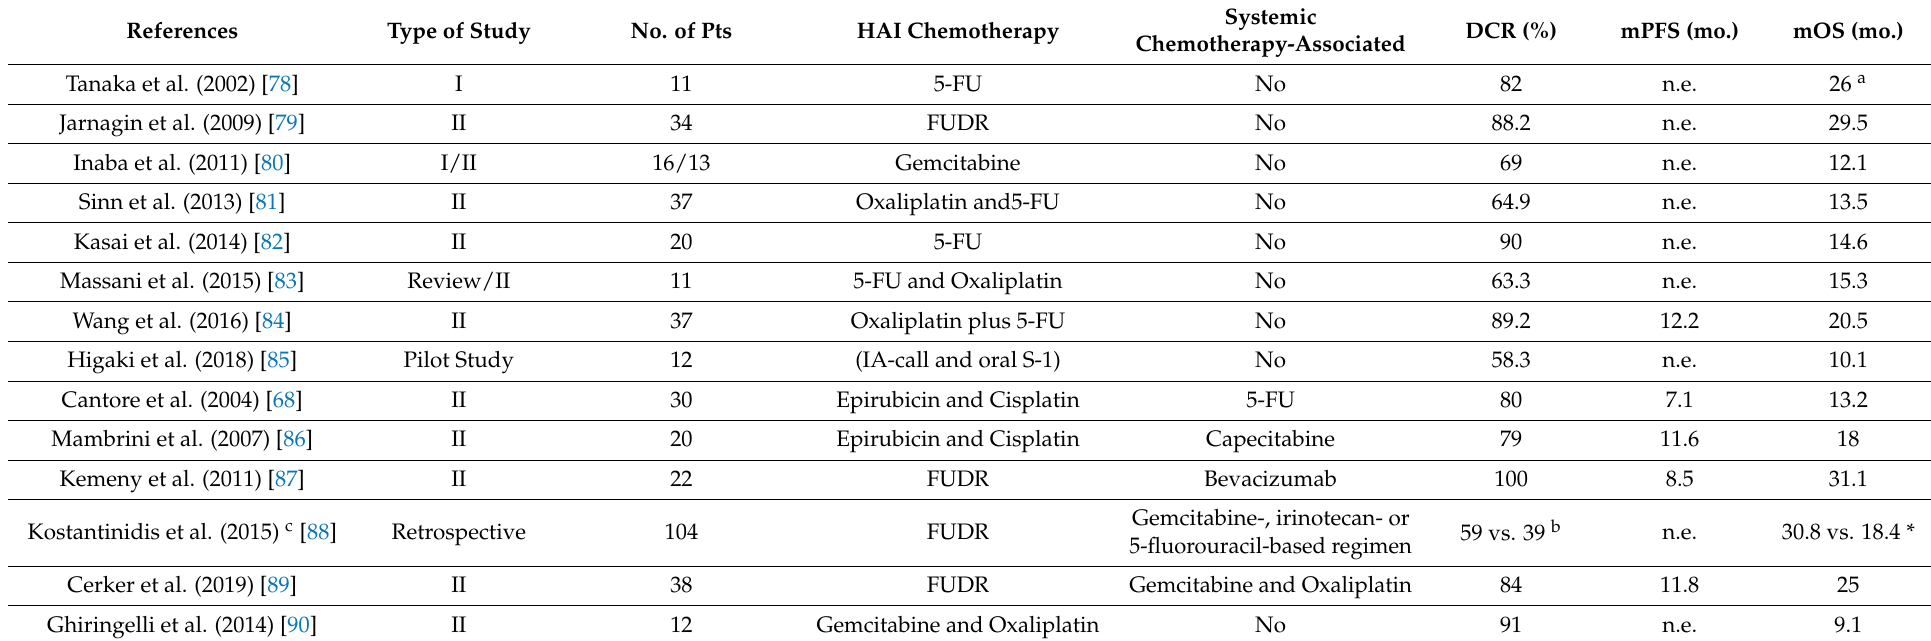
Table 3. Compilation of references included in the review of literature that evaluated HAI chemotherapy in patients with advanced